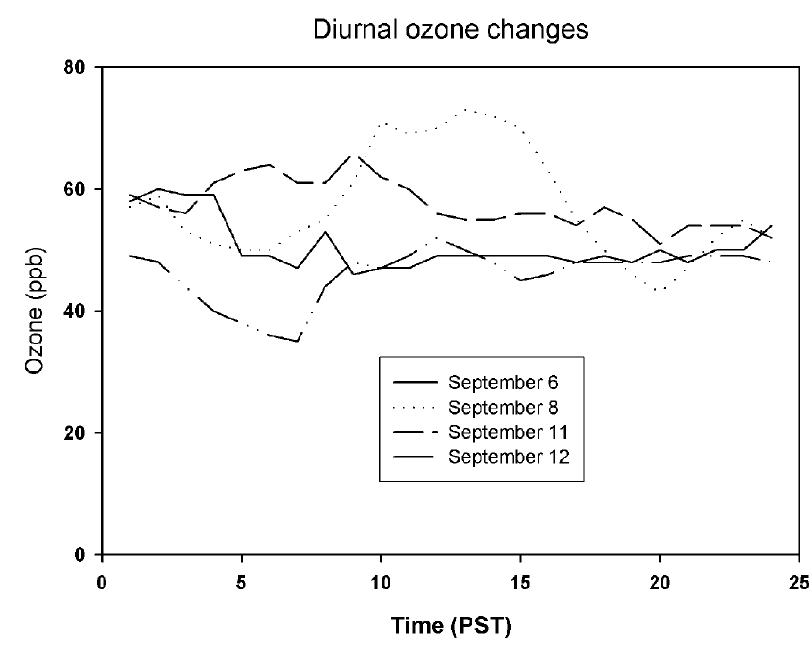
FIGURE 4 . Concentrations of O 3 determined with an active UV absorption monitor at the Mammoth Mountain